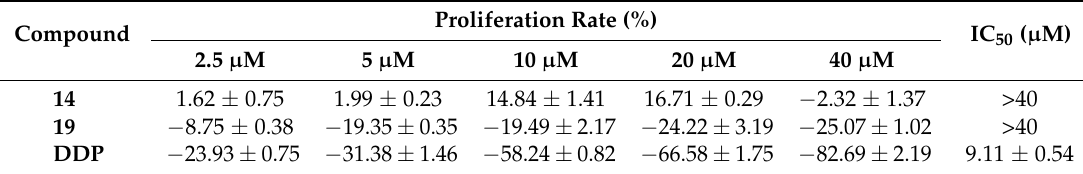
Table 4. Proliferation rates of TMP-flavonoid derivatives on HUVEC-12 for 24 h. Data were expressed as inhibitory ratio ± SD based on three independent experiments ( n =